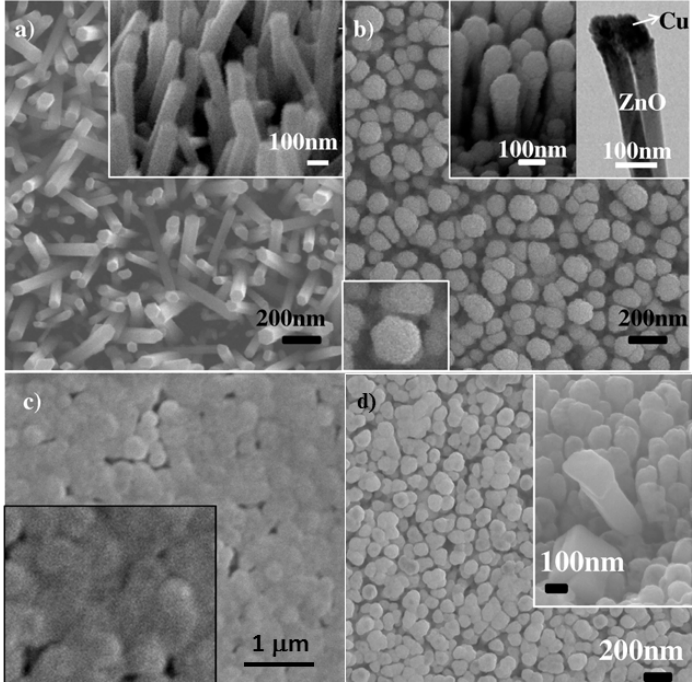
Figure 19. Cu film oxidation on ZnO nanowire arrays: Top view SEM images ( a ) ZnO nanorods grown by hydrothermal method, inset: a 30° tilt view of nanorods; ( b ) ZnO-Cu core-shell nanorods after deposition of Cu and upper right inset (left) showing their nail-shaped structure, upper right inset (right): TEM image of ZnO-Cu core-shell nanorods; bottom left inset: zoom in view of a hexagon shaped nanorod tip; ( c ) ZnO-Cu core-shell nanorods annealed at 400 °C in ambient air for 30 min, inset: zoom in view of “flat” and continuous CuO film bridging adjacent ZnO nanrods; ( d ) Top view SEM image